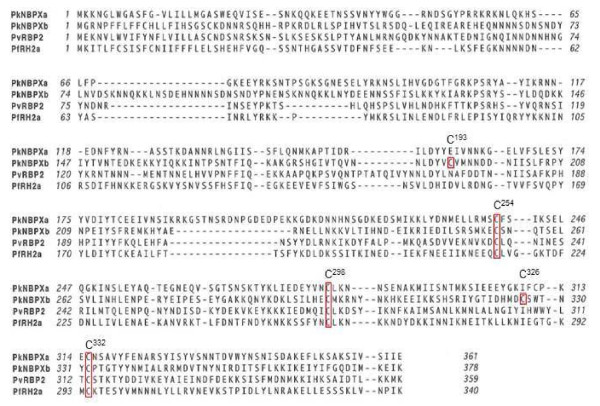
Amino acid alignment of the N-terminal regions of PkNBPXa, PkNBPXb, PvRBP2 and PfNBP2a. Alignment of the first 300–400 amino acids of the N-terminus of PkNBPXa, PkNBPXb, PvRBP2, and PfNBP2a demonstrates conservation of three cysteine residues among species. These three residues in PkNBPXb correspond to Cys254, Cys298, and Cys332. Two other cysteine residues are also present in the N-terminus of PkNBPXb-II and are Cys193 and Cys326.